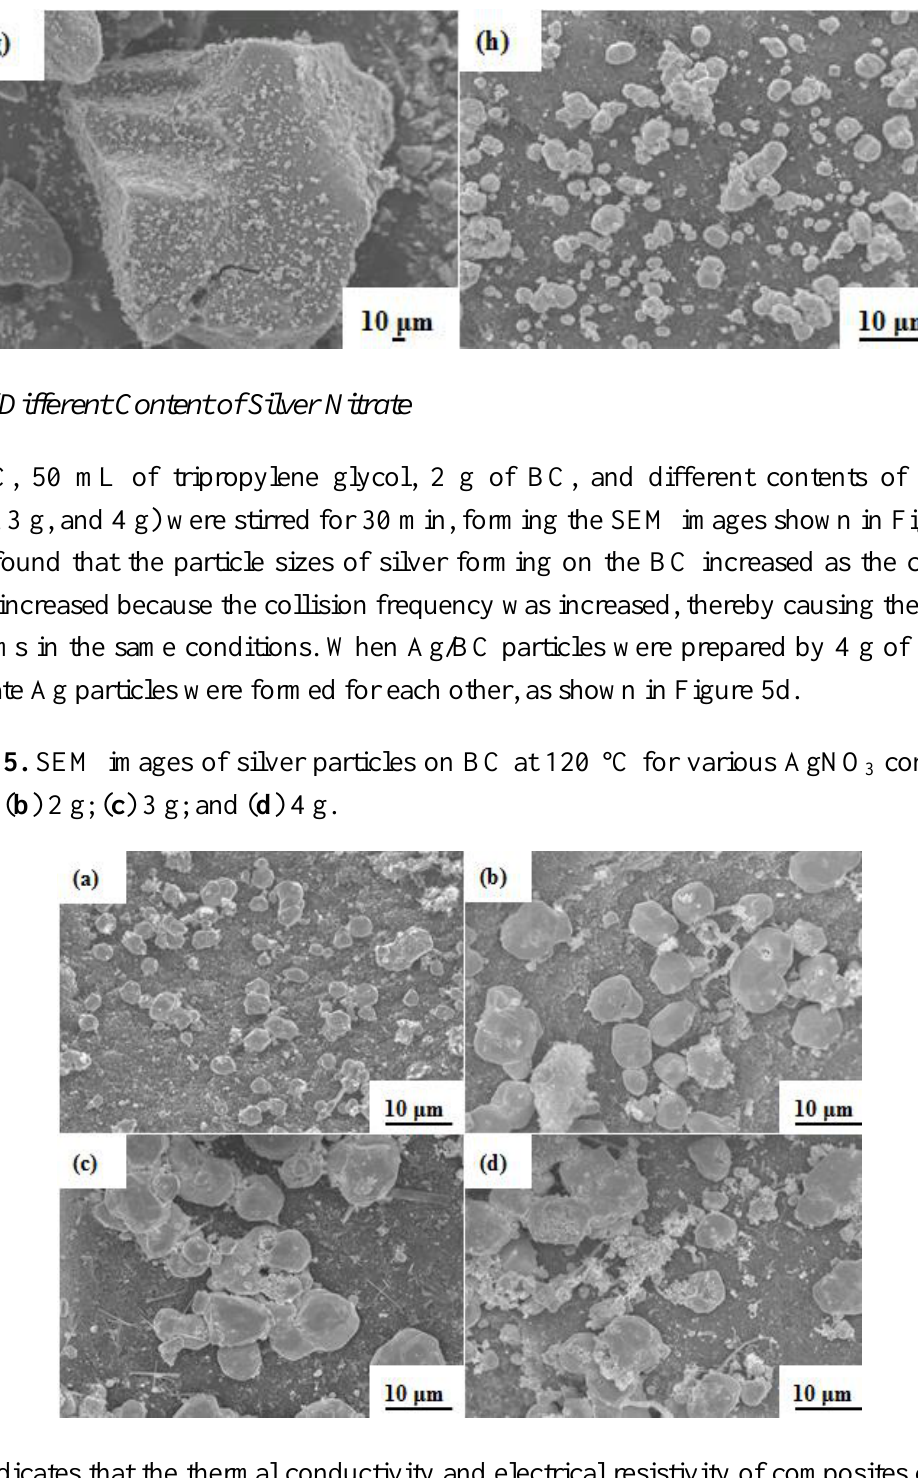
(12 wt% of BC) and 12 wt% of Ag/BC powder due to various silver nitrate preparations. The